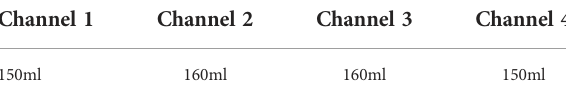
TABLE 2 The water extraction volumes of the four sampling